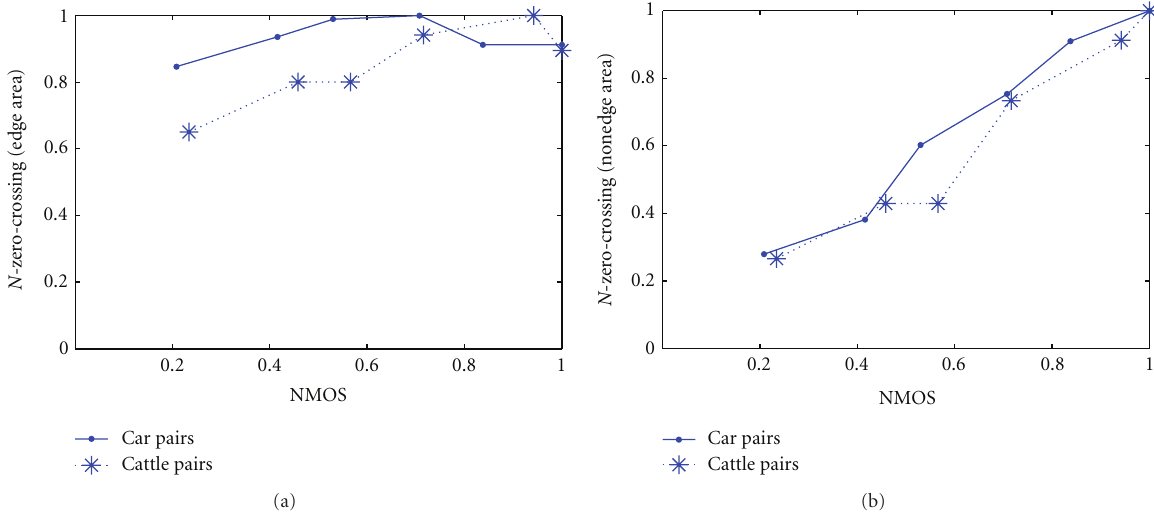
Figure 7: Normalized MOS versus zero-crossing for edge and nonedge areas of di ff erent Car and Cattle image pairs. (a) NMOS versus N -Zero crossing (nonedge areas, ZC N -Zero crossing (edge areas, ZC e ), (b) NMOS versus n ). the two zero crossing features (ZC e and ZC n ) measures along with the minimum zero-crossing are more justified